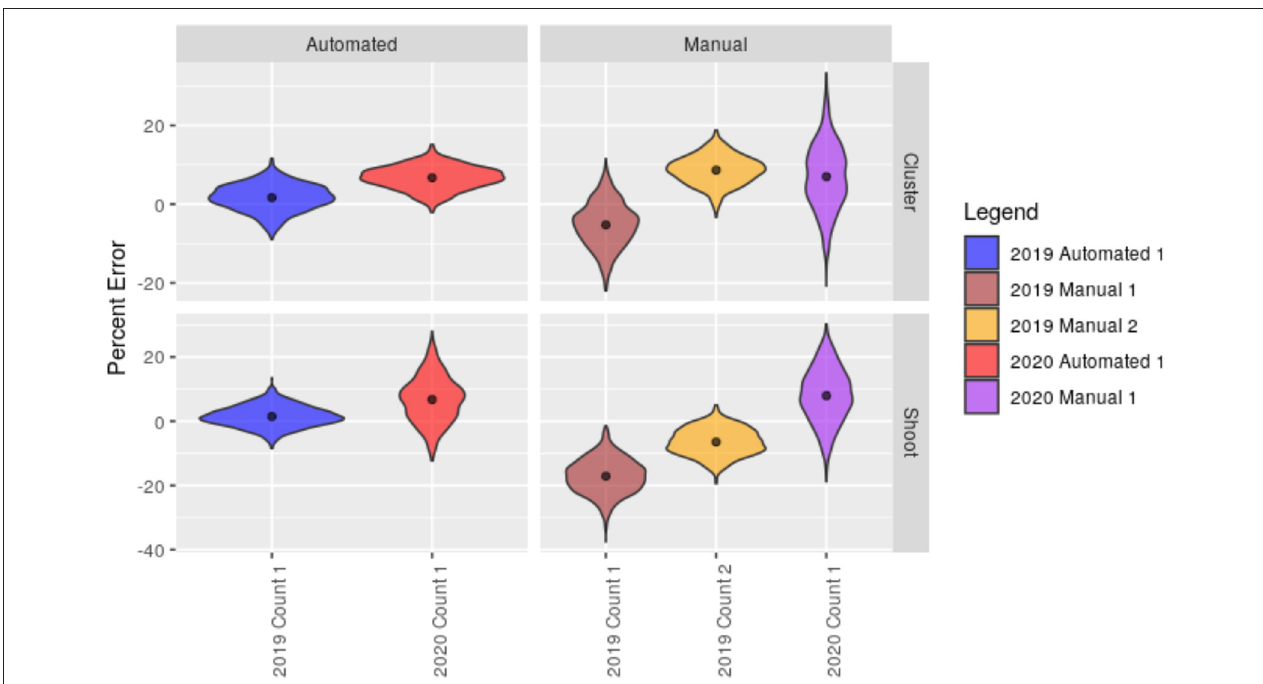
FIGURE 4 | Distributions of percent error in cluster count prediction for automated and manual methods. The black dot represents the mean percent error.